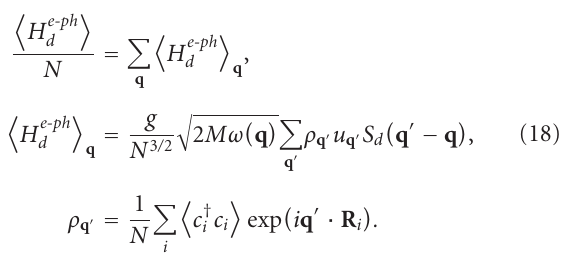
energy per lattice site, h e ( τ ) ≡ (cid:2) H e ( τ ) (cid:3) /N , associated